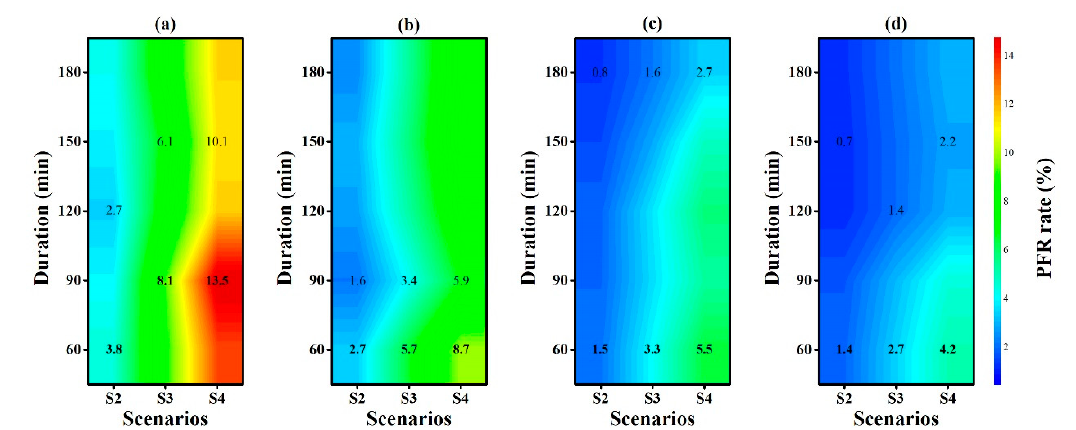
Figure 7. Peak flow reduction (PFR) across three design scenarios (S2, S3, and S4) compared to current conditions (S1) during ( a ) 2; ( b ) 5; ( c ) 10, and ( d ) 20 year rainstorm return periods (RP) of different durations.